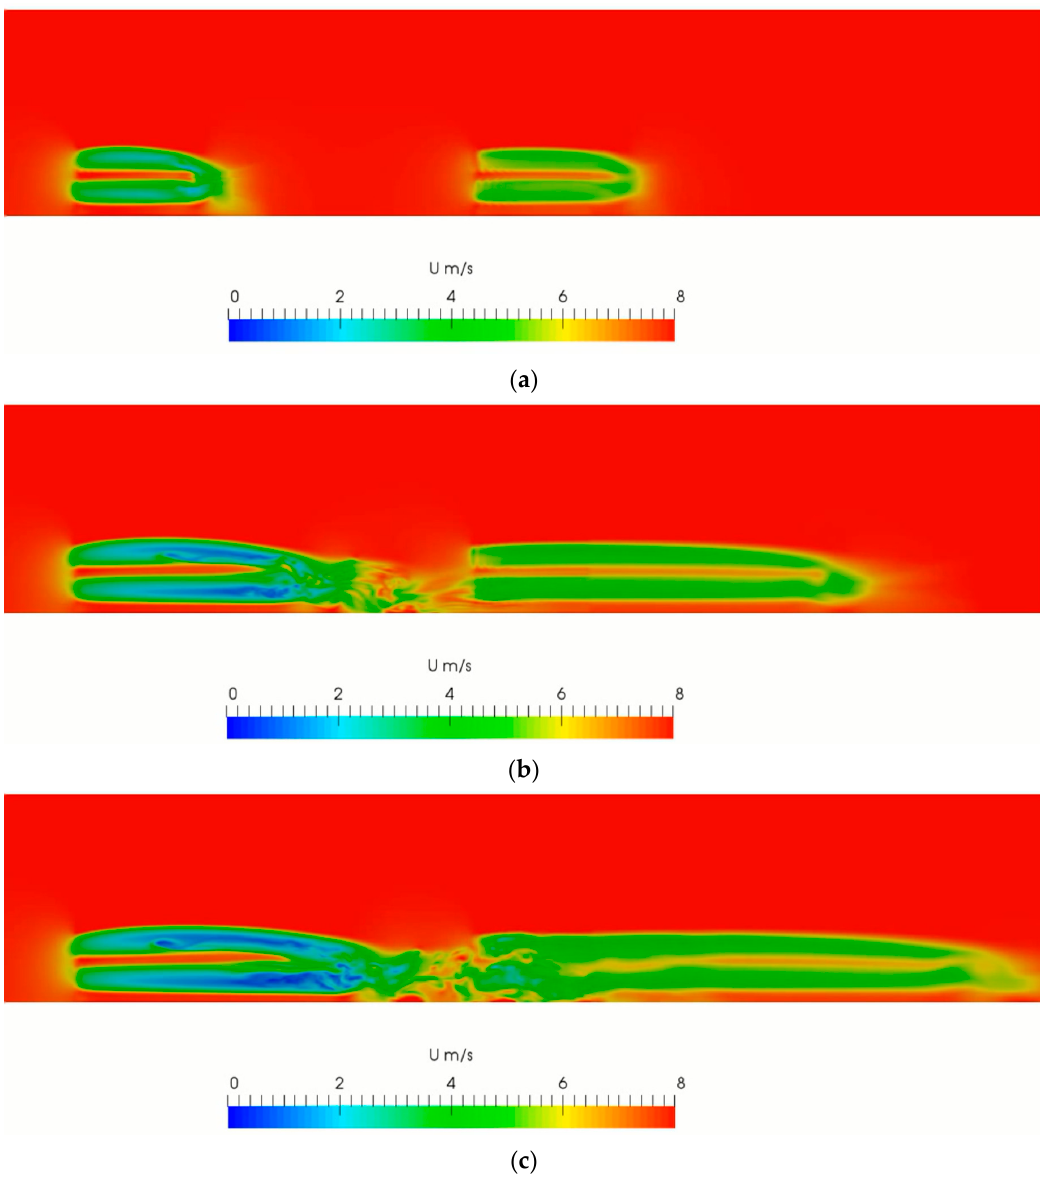
Figure 25. The wake velocity field development of double wind turbine aligned: ( a ) initial status without disturb; ( b ) developing status; and ( c ) interference status.